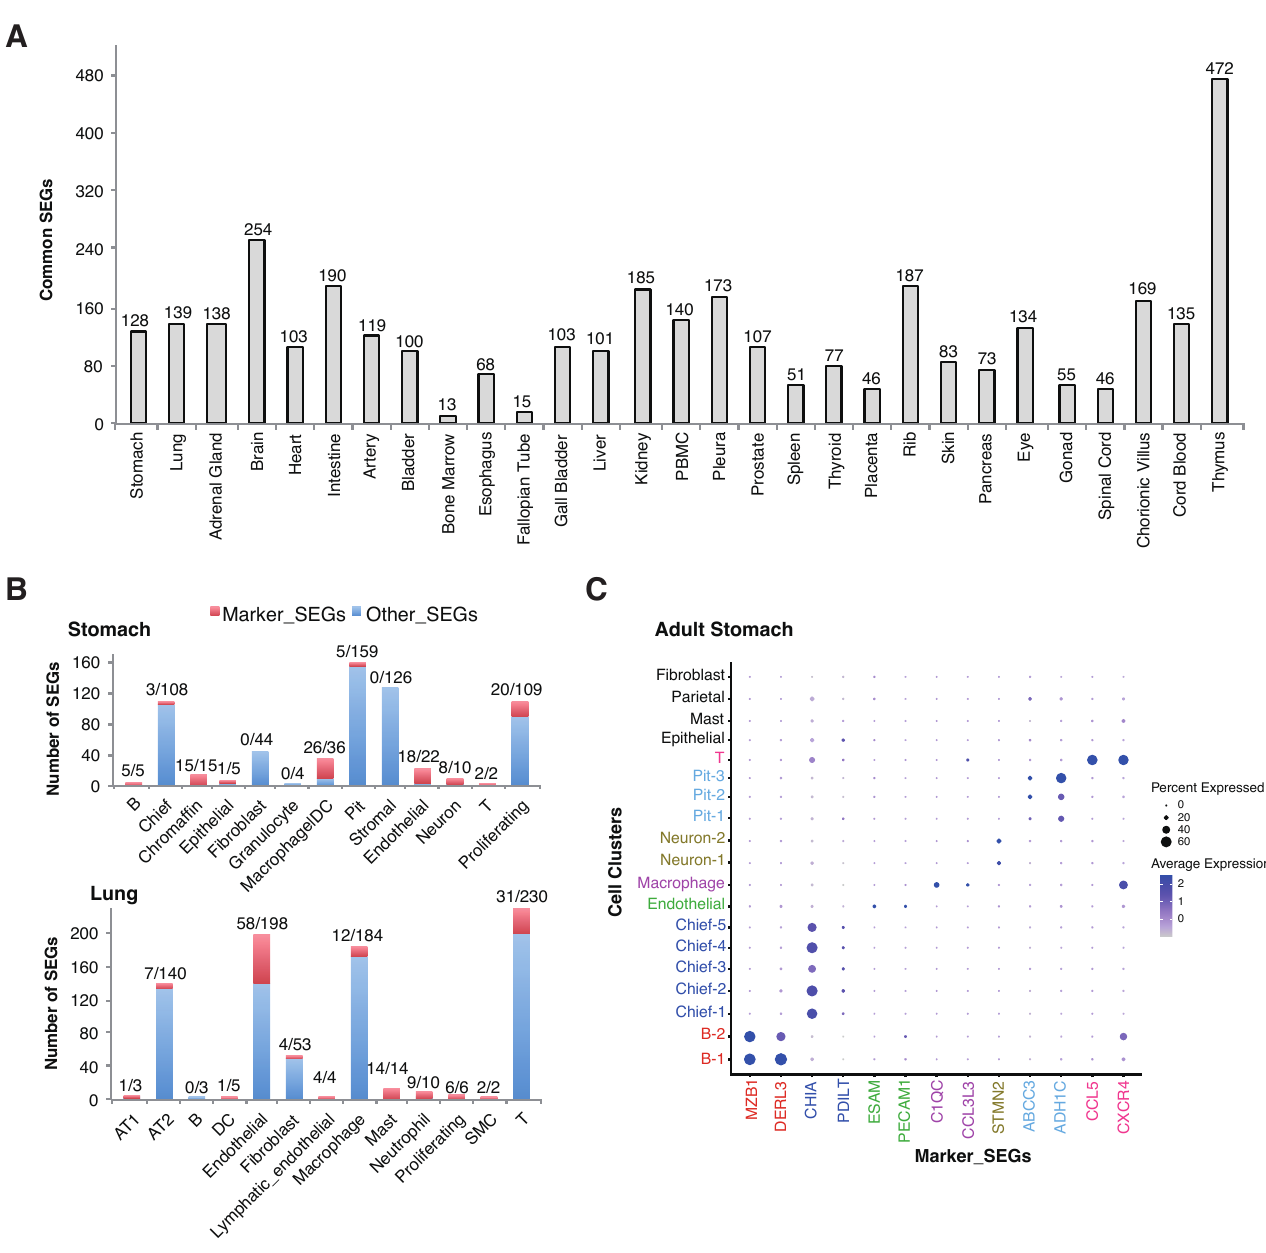
Figure 4. Tissue SEGs and within-tissue cell-specific SEGs. ( A ) Tissue SEGs. The SEGs were common for each cell type within the corresponding tissue. ( B ) Within-tissue cell-specific SEGs and marker SEGs in representative tissues. For each tissue, the composition cell types, the number of cell-specific SEGs, and the number of cell-specific marker SEGs were shown. For the numbers presented as ‘x/y’ on the top of each bar, ‘x’ and ‘y’ represented the number of cell-specific SEGs and marker SEGs, respectively. Marker SEGs represent SEGs that are expressed specifically or with striking higher level in indicated cell types and can be used as gene markers for the corresponding cells. ( C ) Expression of representative cell-specific marker SEGs in cell clusters of a representative sample. The representative stomach sample was selected from [25]